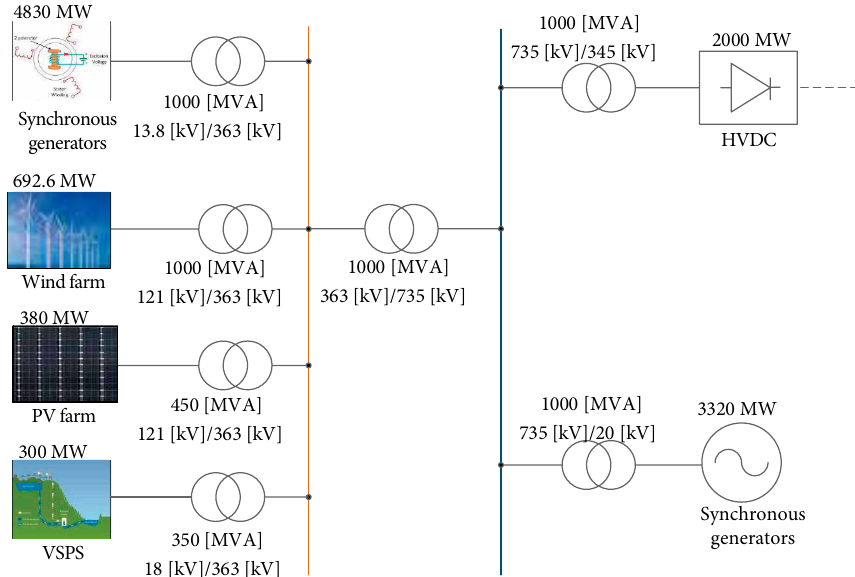
Figure 6: Structure of the proposed system to mitigate the effects of SSR in the power system.